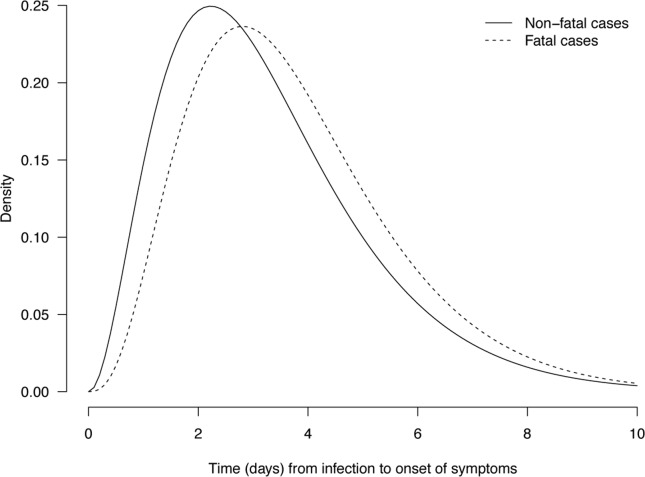
Parametric estimates of the incubation period distribution for fatal (dotted line) and non-fatal cases (solid line) of laboratory-confirmed influenza A(H7N9) virus infection.The parameters of the weibull distribution were estimated with the MCMC approach in the fatal and non-fatal cases, respectively. The estimates are for fatal cases: k = 2.30 (95% CrI: 1.80, 2.89) and θ = 4.21 (95% CrI: 3.62, 4.85) and for non-fatal cases: k = 2.03 (95% CrI: 1.62, 2.52) and θ = 3.74 (95% CrI: 3.20, 4.36).